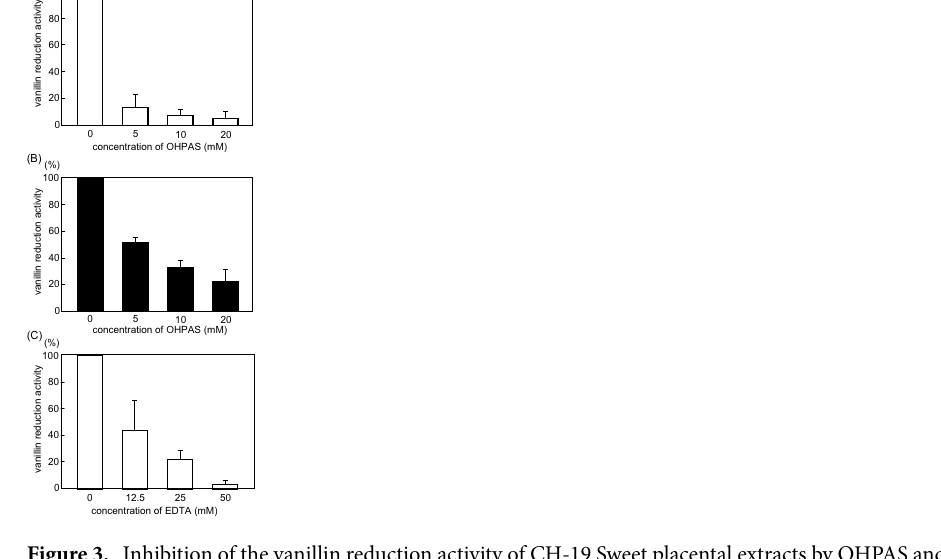
Figure 3. Inhibition of the vanillin reduction activity of CH-19 Sweet placental extracts by OHPAS and EDTA. Vanillin reduction activity of placental extracts from ( A ) immature green and ( B ) mature red fruits was inhibited by 0–20 mM OHPAS. ( C ) The activity of immature green fruits was inhibited by 0–50 mM EDTA. The amount of vanillyl alcohol synthesized without inhibitors was set as 100% and used to calculate the degree of inhibition. Experiments were performed using three individual fruits ( n =